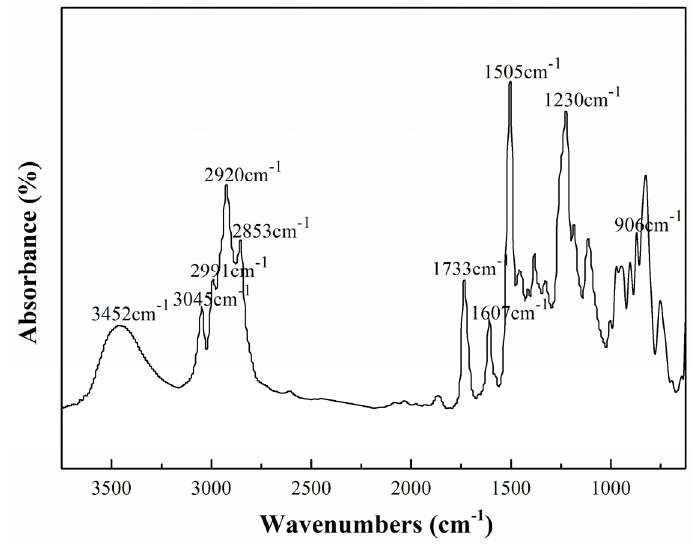
Figure 3. FTIR spectra of the 6%DFA-TGDDE